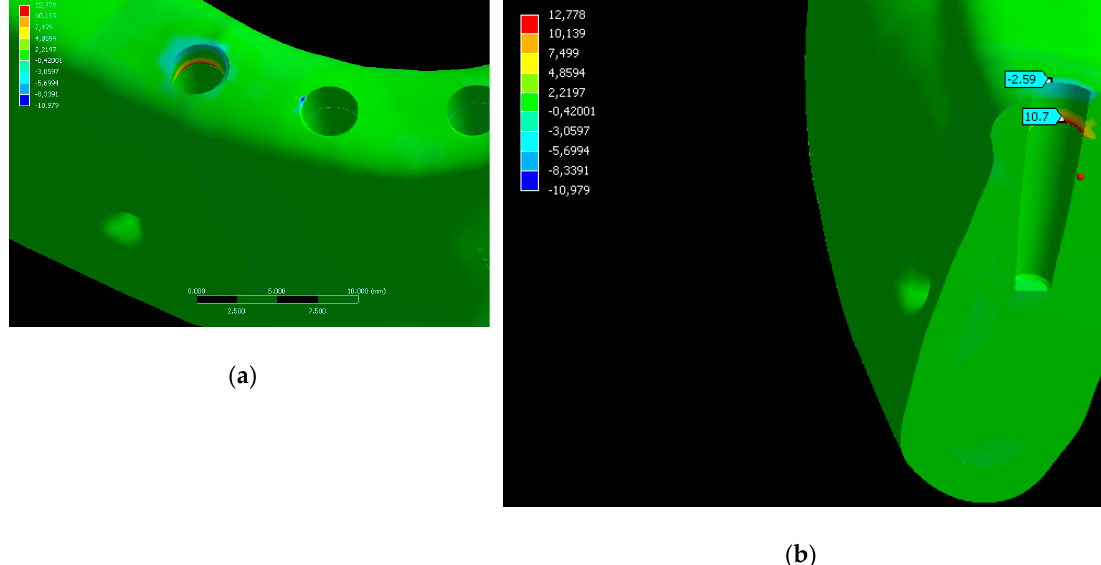
Figure 8. Maximum principal stress [MPa] in the M2 group: ( a ) three-dimensional view; ( b ) transversal cut of the bone.